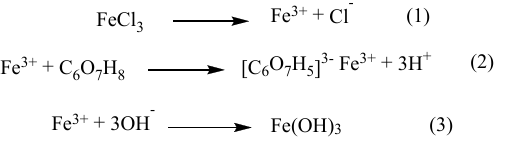
297 J Nanostruct 9(2): 287-300, Spring